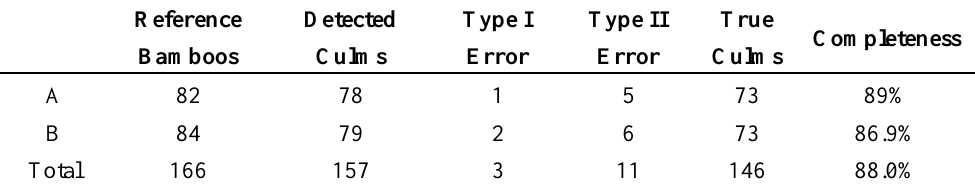
Table 4. Results and assessments of stem